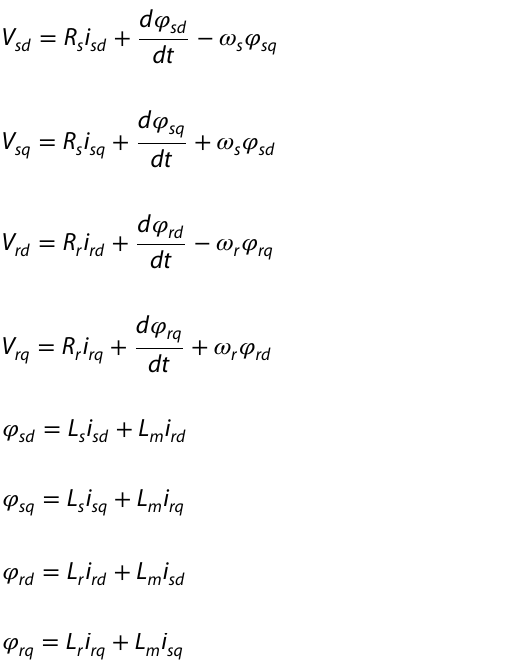
Fig. 2 Control scheme for optimum torque